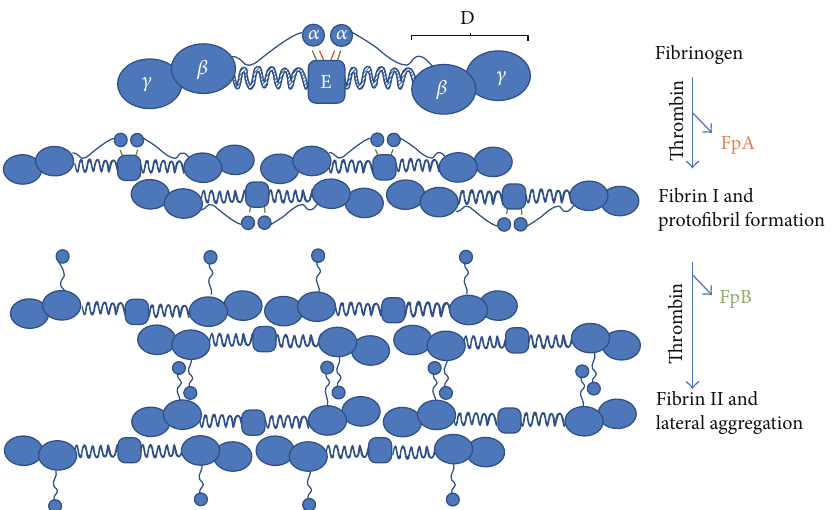
Figure 1: Schematic representation of the fibrin aggregation process. Fibrinogen is composed of two sets of A 𝛼 -, B 𝛽 -, and 𝛾 chains. Each 𝛼 -chain is connected with E-region through fibrinopeptide A (FPA, orange) and fibrinopeptide B (FPB, green). The D-region is linked with E- region through a coiled segment. Thrombin-mediated cleavage of FPA induces the formation of two-stranded protofibril. Subsequent cleavage of FPB releases 𝛼 -chain from E-region and contributes to the lateral aggregation of two-stranded protofibrils and fibrin formation [24].